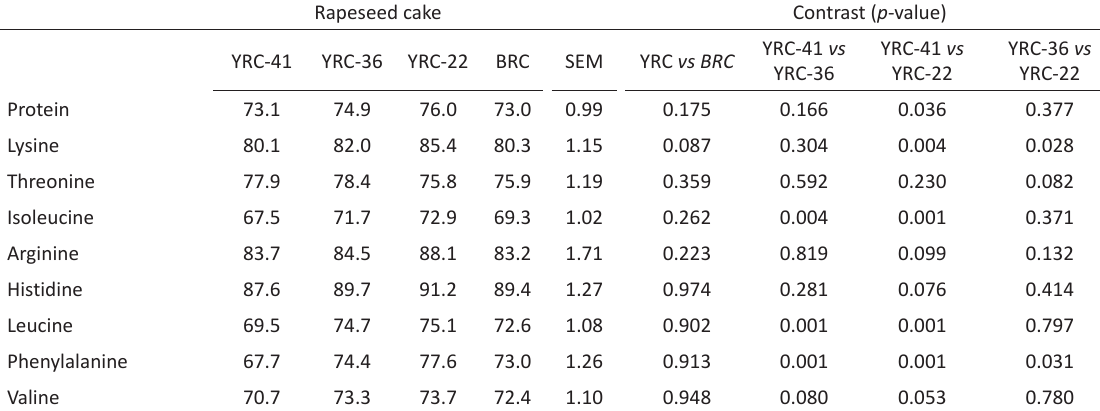
Table 4. Standardised ileal digestibility of protein and amino acid (%) in rapeseed cakes (Experiment 1) Rapeseed cake Contrast ( p